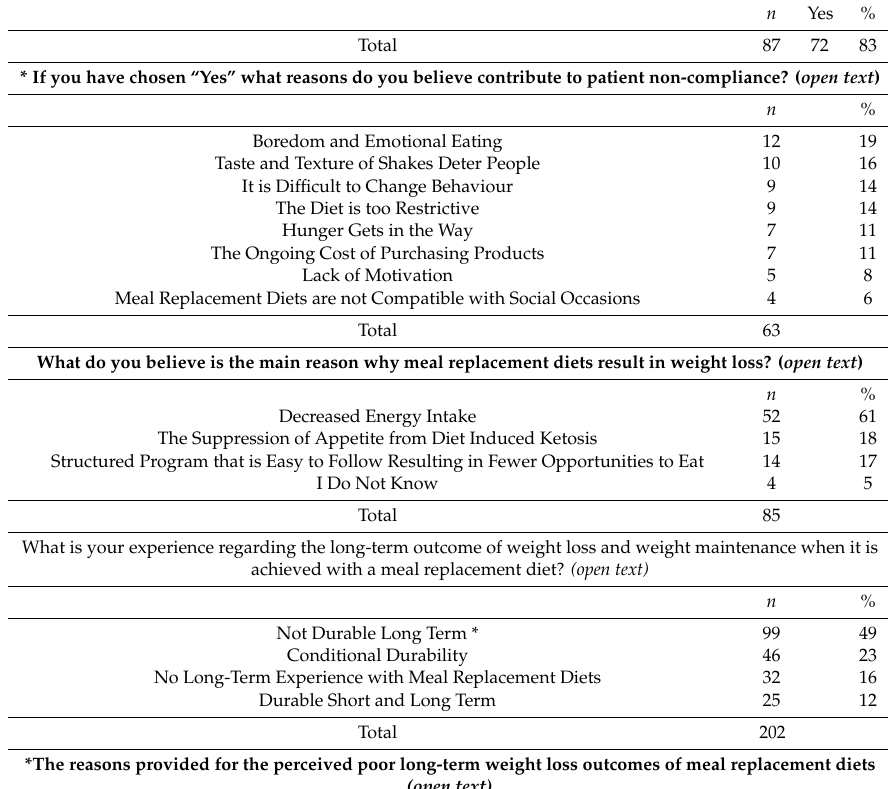
Table 3. Perceptions of healthcare professionals around compliance with, durability of results from, and safety of meal replacement